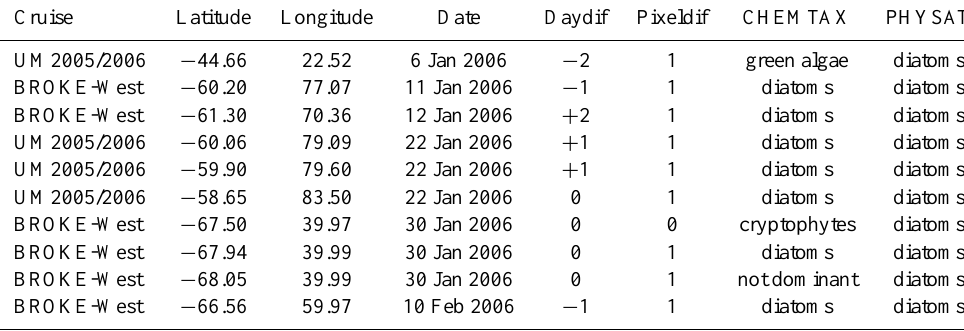
Table 6. Comparisons between CHEMTAX and PHYSAT